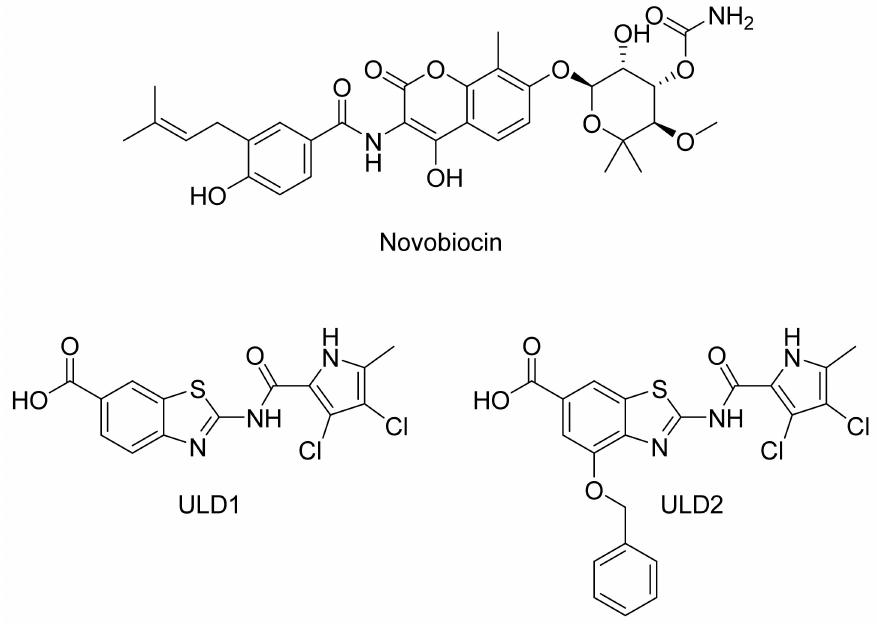
Figure 1. Structures of novobiocin and representative dual GyrB/ParE inhibitors ULD1 and ULD2. The ULD compounds displayed limited resistance development compared to